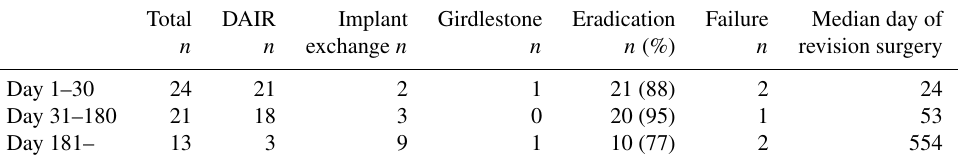
Table 5. Distribution and outcome of postoperative infections during different time intervals after total hip arthroplasty (THA). Day 0 = time point for THA. Failed DAIR in 3 patients resulted in 58 treatment procedures in 55 patients. Total DAIR Implant Girdlestone Eradication Failure Median day of n n exchange n n revision